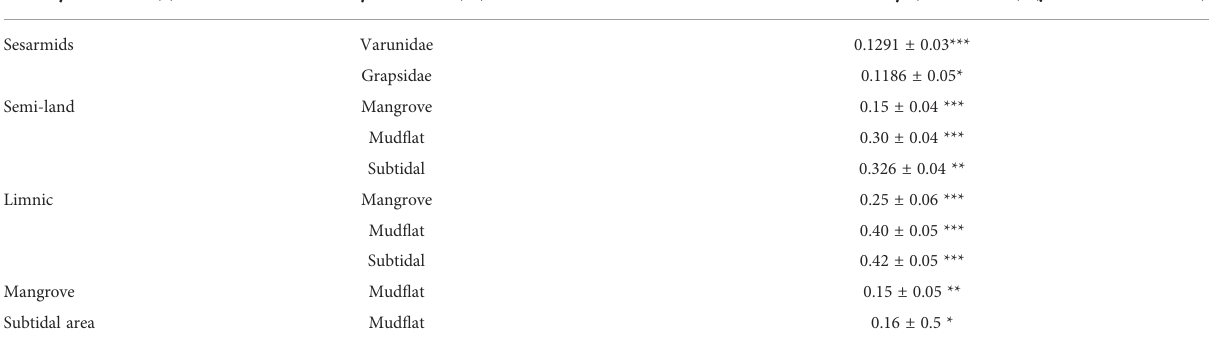
TABLE 4 Comparison of BG activity of crabs from different families and habitats. Family / Habitat